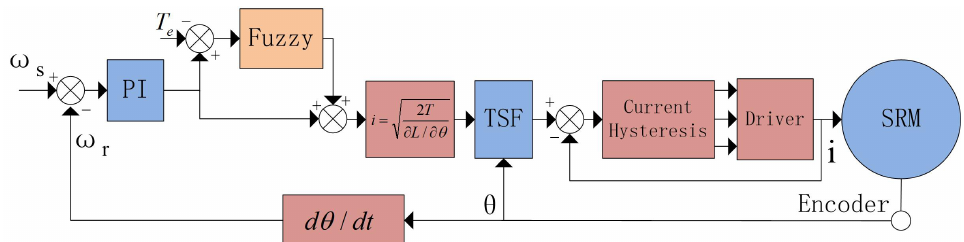
Figure 2. Reference torque compensation by fuzzy